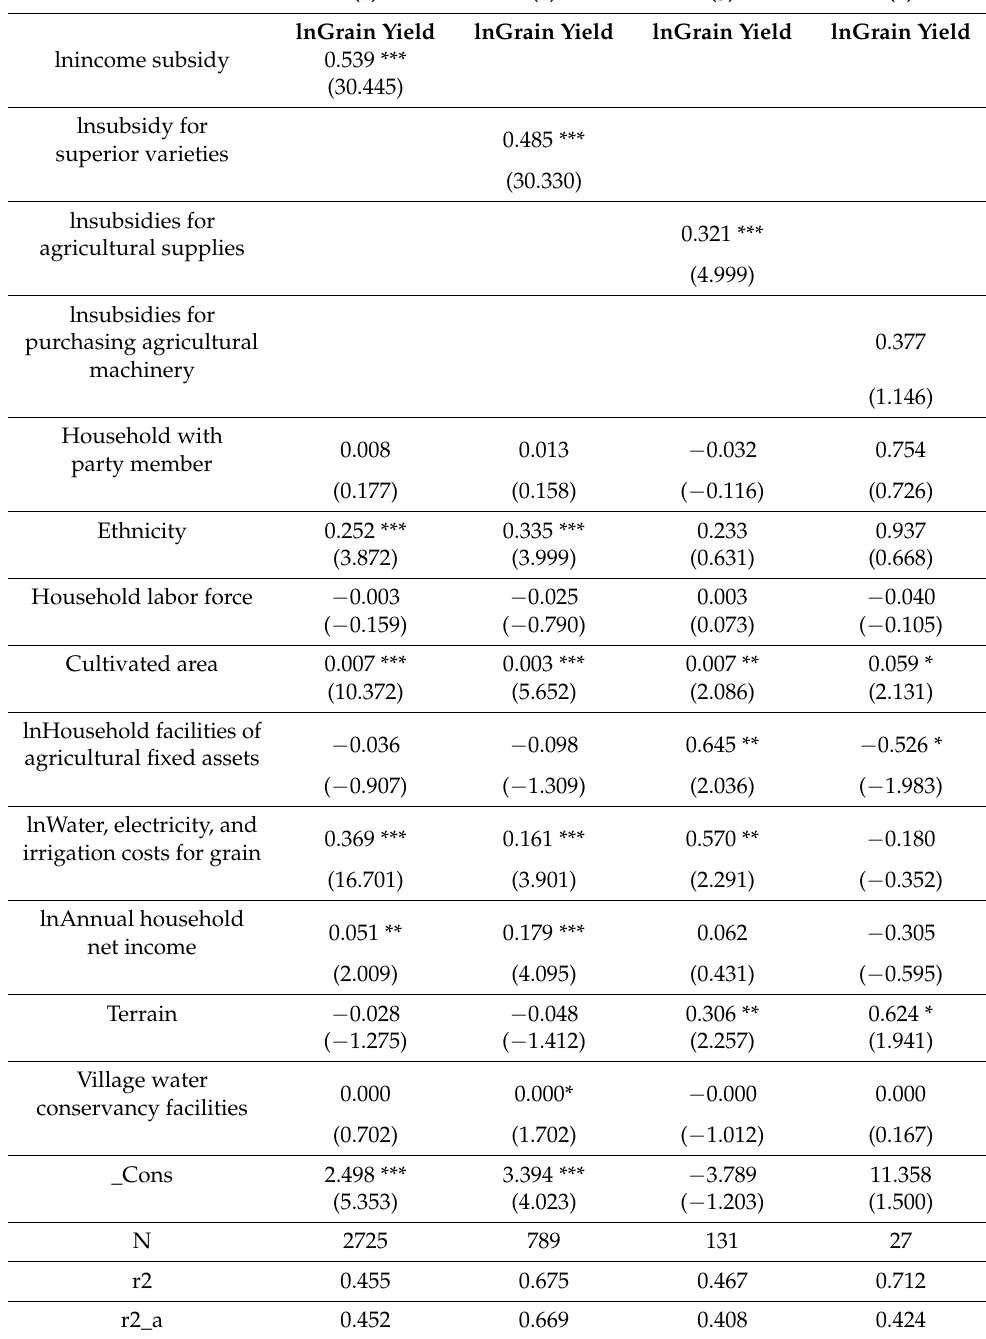
Table 6. The heterogeneous results of the types of agricultural